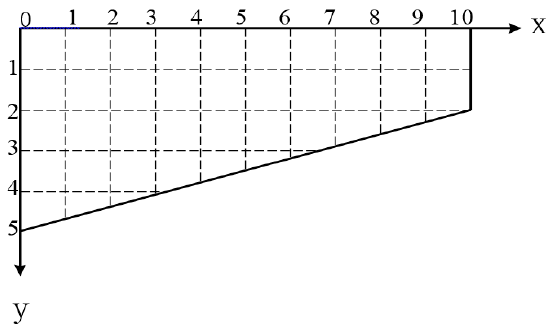
Figure 4. Schematic diagram of bed coordinates. Table 3. Compound dry separation average density of particles in the bed test sampling layout table.